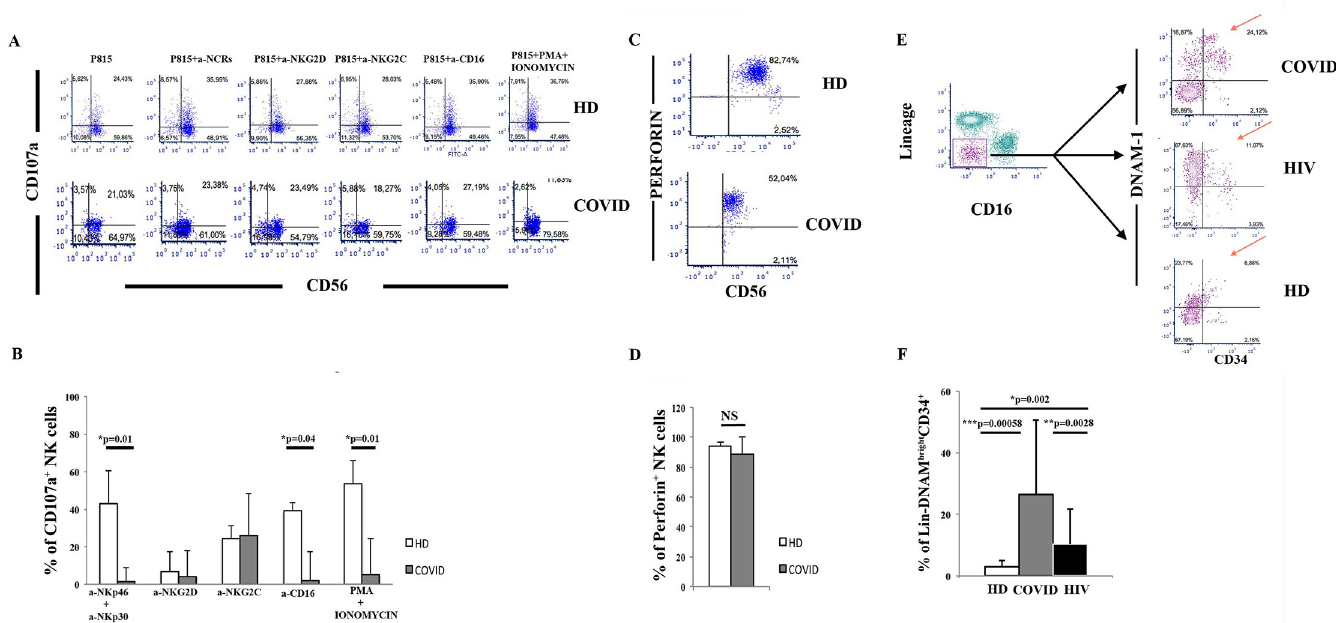
Fig 4. Functional study of circulating NK cells and of their peripheral turnover through analysis of “inflammatory” CD34+DNAM bright CXCR4+ precursors. Panel A: In vitro NK cell cytotoxicity assay by flow cytometric analysis of CD107a expression in a representative COVID-19 patient and HD. A redirected killing (reverse ADCC) is shown, using NKp46 and NKp30 NKG2D, NKG2C, CD16 mAb-mediated triggering in the presence of Fc γ + P815 cells. Left: no mAb. Center: NCRs ( α -NKp46+ α NKp30, α - NKG2D, α -NKG2C, α -CD16). Right: the total lytic potential (as tested by maximal stimulation with PMA+ionomycin) of circulating NK cells is decreased in COVID-19 patients. Dots indicate CD107a degranulation 4 hours after NK cell triggering with the indicated stimulus. Panel B: In vitro cytotoxicity of PB NK cells as determined by CD107a expression in COVID-19 patients (n = 8) vs. HD (n = 8) is not inducible. Histograms show mean ± SD. Mann-Whitney U-test analysis is shown. Panel C: Perforin expression by NK cells in COVID-19 patients is conserved. Representative flow cytometric analysis of CD3-CD19-CD14-CD56 + NK cells expressing perforin. 10000 events are analyzed. Panel D: The proportion of perforin+ NK cells is conserved in COVID-19 patients. Histograms indicate the proportion of Perf+ NK cells over total CD56+ NK cells, mean ± SD. Panel E: Flow cytometric gating strategy and analysis of DNAM-1 and CD34 expression on Lin- CD16- cells in a representative COVID-19 and a HIV-1 patient and a control HD. Lineage = CD3, CD14, CD19, CD56. A representative COVID-19 patient (upper plot), HIV patient (middle plot), and HD (bottom plot) are shown. Box and arrow indicate the area of DNAM-1 bright appearance of CD34+ circulating precursors. Panel F: Cumulative circulation of CD34+DNAM-1 bright CXCR4+ common lymphocyte precursors in COVID-19 patients (#28) is increased compared to HD (#18) and also to HIV-1 patients (#15). Histograms show mean ± SD. Mann-Whitney U-test analysis is shown.